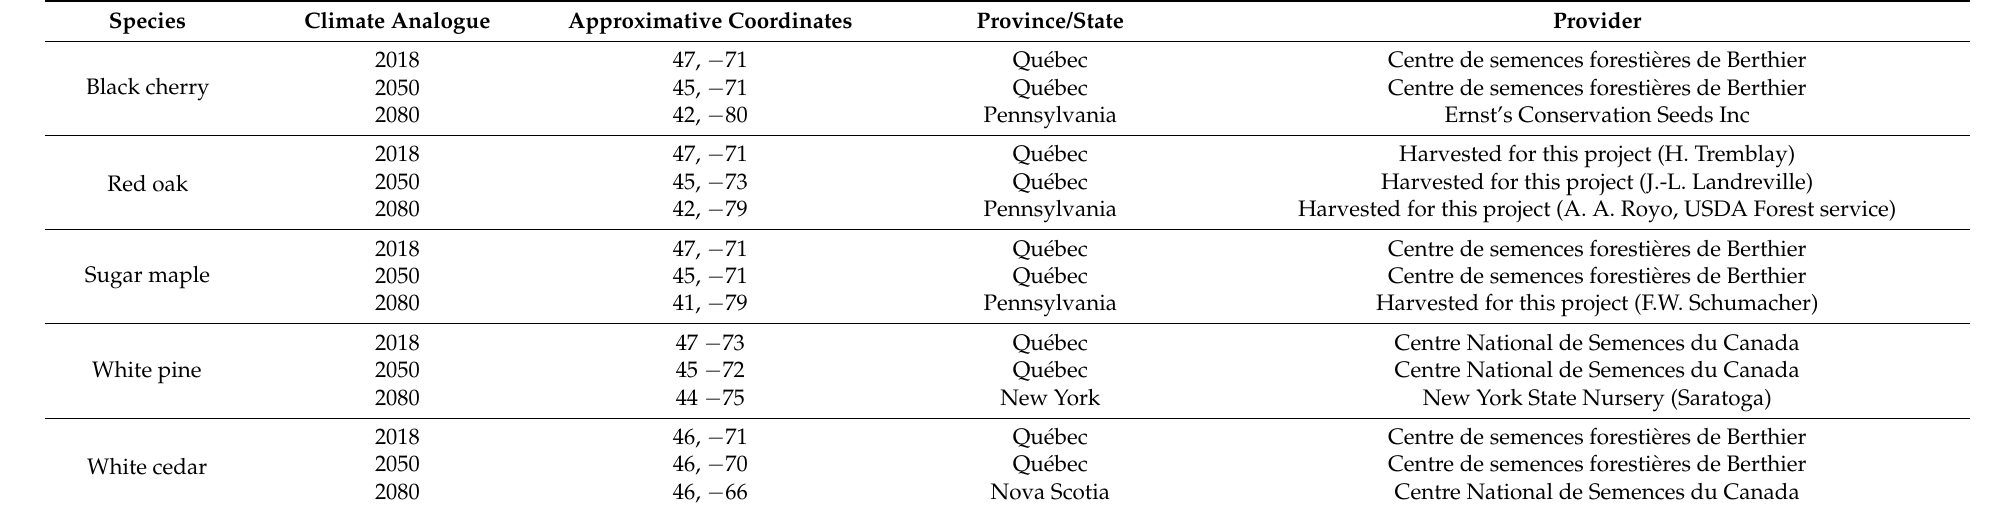
Table A1. Seed sources for climates analogues, including approximative coordinates and provider.